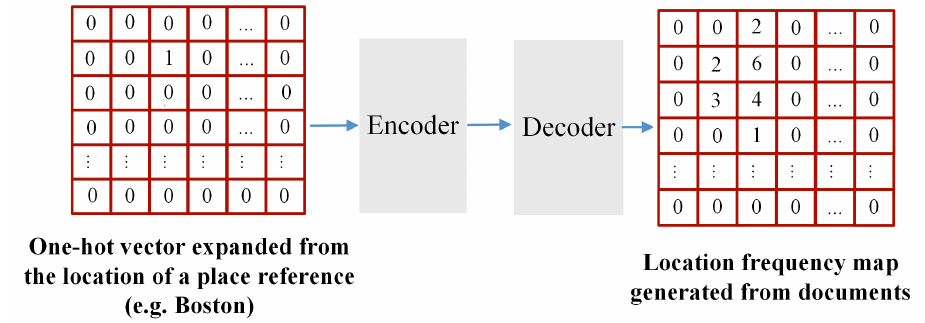
Figure 2. The auto-encoder networks for location